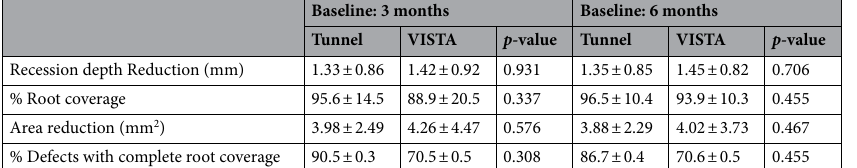
classification (p = 0.531) or the technique (p = 0.549). Also, no correlation was found between the papilla height and root coverage at both 3 months (p = 0.698) and 6 months (p = 0.315). Healing dynamics of treated sites. The results of the volumetric assessments performed are shown in Supplementary Table 3. The soft tissue gained at 3 months was regarded as the standard value of soft-tissue aug- mentation, the grafted sites showed a mean gain at 3 months of 4.45 (± 3.42) mm 3 in the TUN + CTG Group and 5.27 (± 5.79) mm 3 in the VISTA + CTG Group (p = 0.772). At 6 months, the treated sites showed a mean gain of 4.72 (± 3.88) mm 3 in the TUN + CTG Group and 5.43 (± 5.21) mm 3 in the VISTA + CTG Group (p = 1.000). From T1 to T2 (6 months), there was a mean volume increase of 13.2% (± 5%), where the TUN + CTG Group showed a higher mean volume increase of 18.9% ± 58.4%) and the VISTA + CTG Group of 8.1% (± 53.1%) (p = 0.710). The clinical outcomes can be observed in Fig. 2A and B.